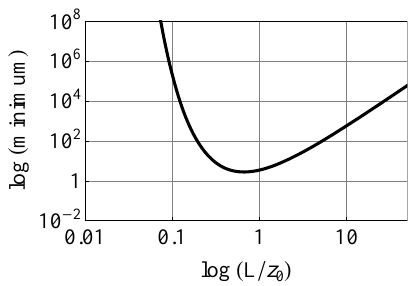
Figure 8. Illustration of the right hand side of the inequality Eq. (33) for varying L/z 0